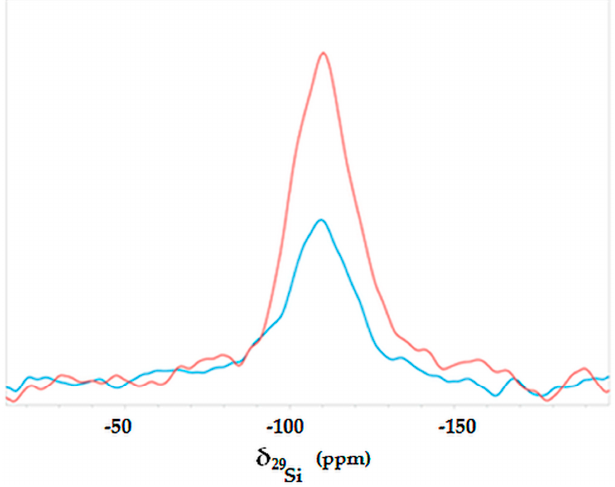
Figure 5. 29 Si NMR spectra of hemp (H, blue) and treated hemp (HT, red) samples acquired at a spin rate 10,000 Hz.